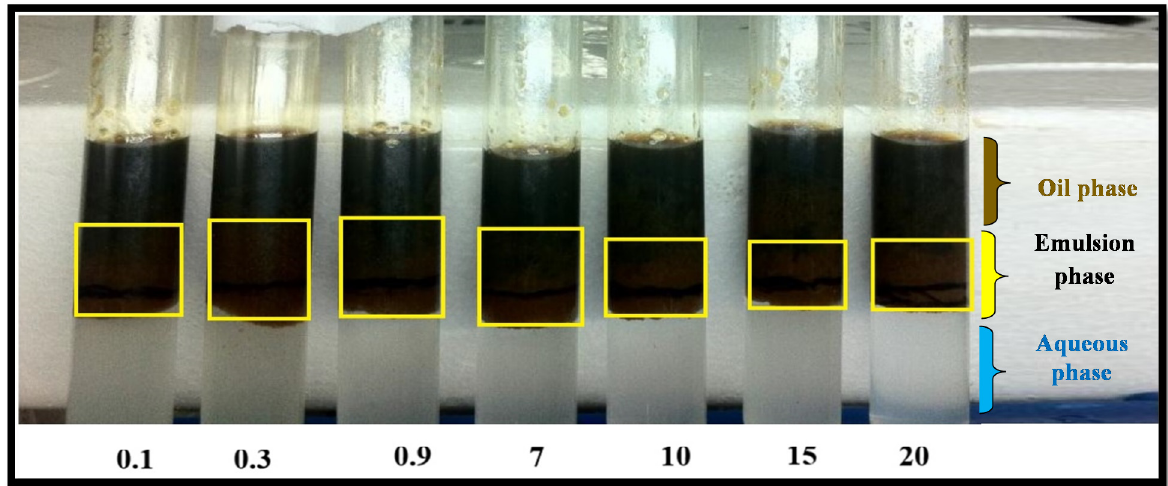
Figure 7. Phase behavior of crude oil in brine emulsions stabilized by RAG1 cells (1500 ppm) at different salinities in % w / v .